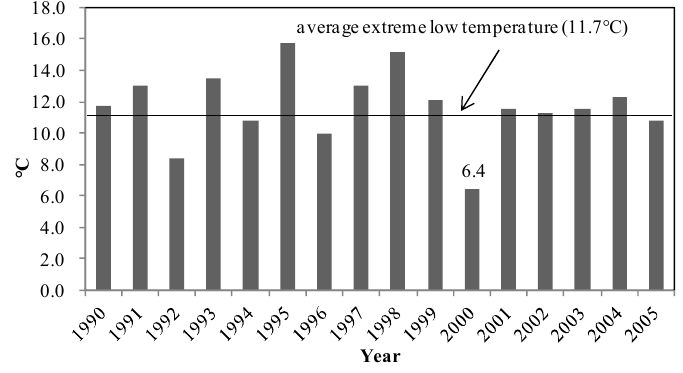
Figure 3. Extreme low temperature in December from 1990 to 2005 in the study watershed.